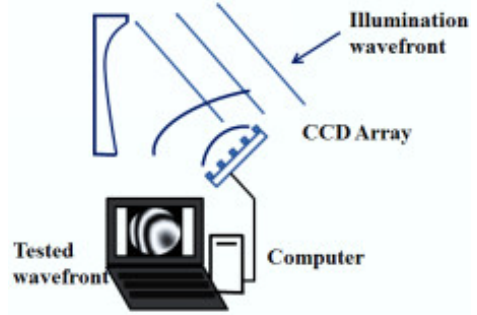
Figure 2. The schematic of optical surface measurement with PR.